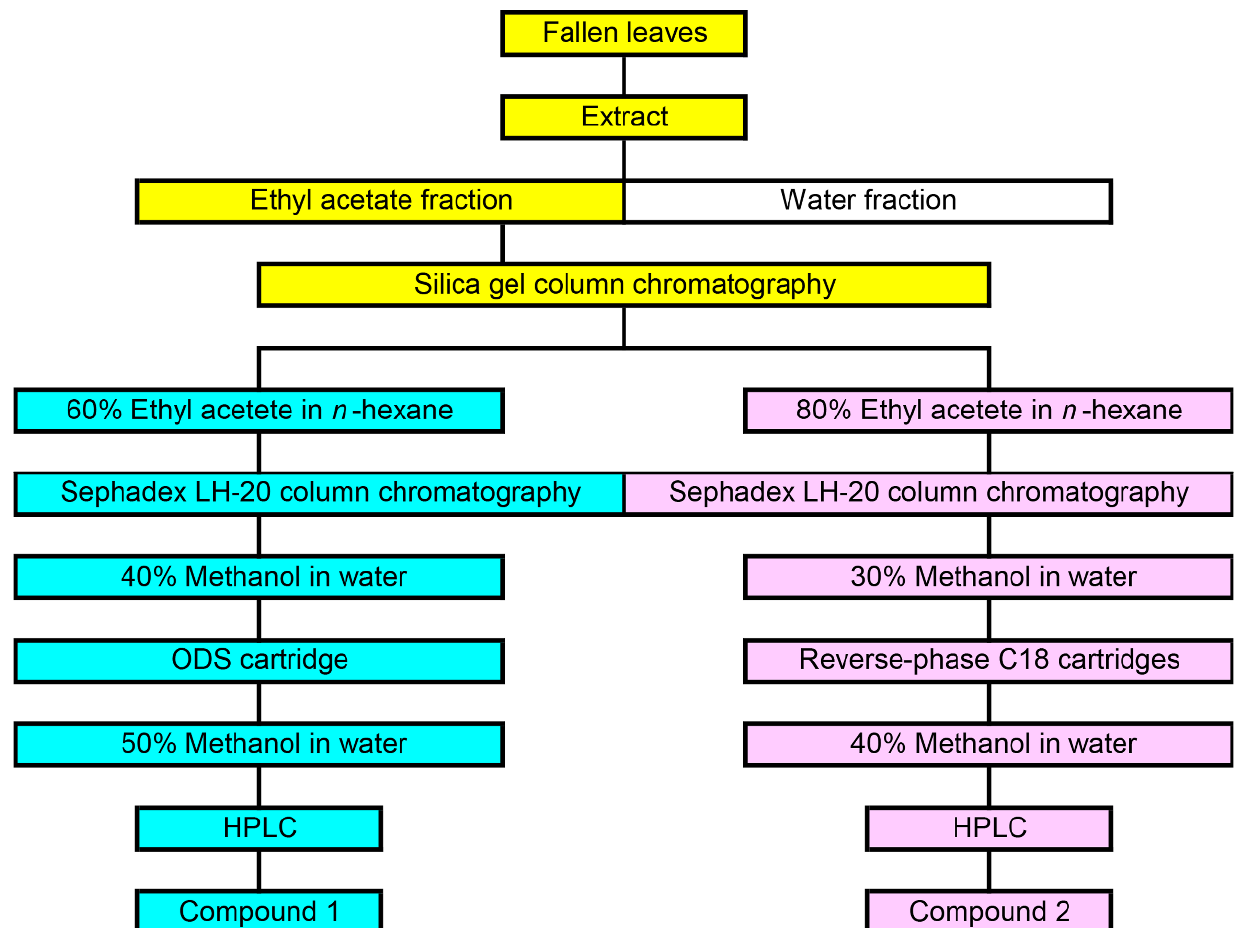
Figure 4. Isolation process of compound 1 and 2 from the extract of M. glyptostroboides fallen leaves.